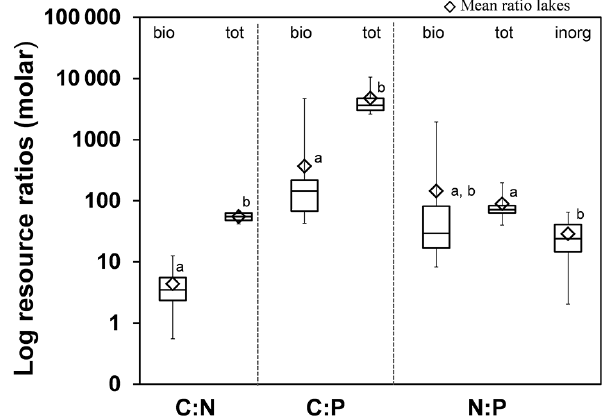
Figure 4. Bioavailable (bio) and total (tot) ratios (molar) of carbon to nitrogen (C:N) and carbon to phosphorus (C:P) for all lakes and all sampling dates ( n = 26). Ratios of N:P are shown for total, bioavailable, and inorganic (inorg) fractions. Different letters stand for significant differences (dependent t test; p <0.05; n = 26) among ratios. Data shown as box plots and includes mean as diamonds.